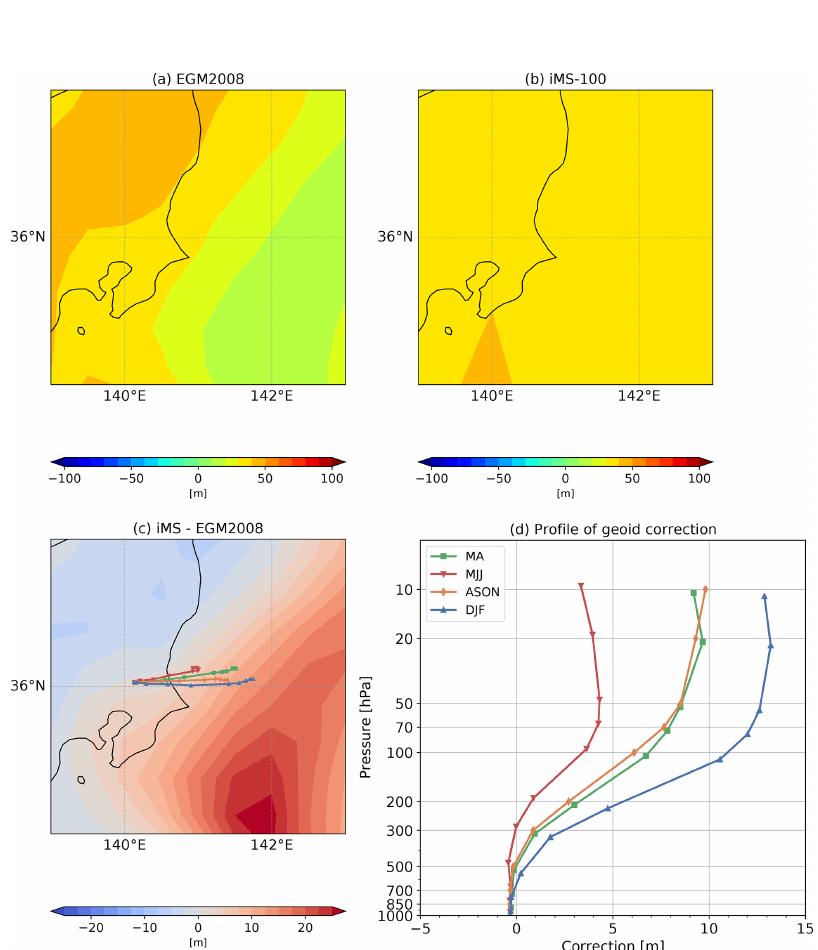
Figure 28. (a) Geoid height for iMS-100-GDP, (b) iMS-100 original values, (c) difference in geoid height and seasonal typical tracks, and (d) correction values along typical